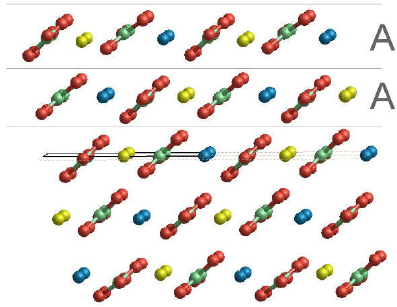
Figure 1. Optimized structure of the (10.4) slab of dolomite cut from the bulk structure SC1. The slab is composed of a sequence of equal layers (… AAA …). Ca: blue, Mg: yellow, C: green and O: red.